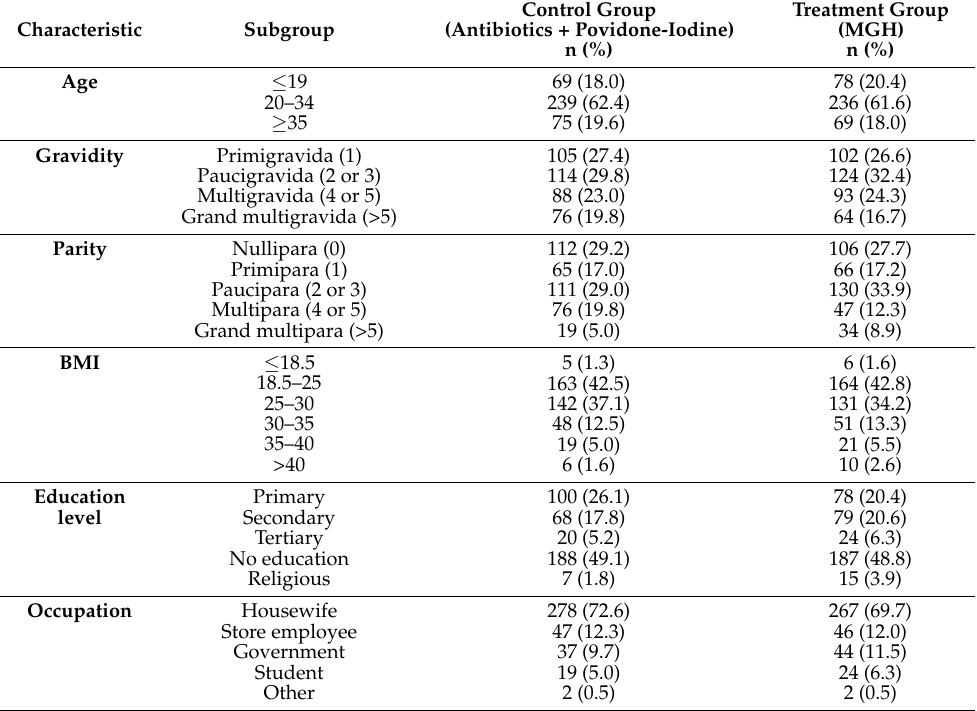
Table 1. Baseline characteristics of the study population (383 patients per group). Patient characteris- tics are divided into subgroups and presented separately for both study